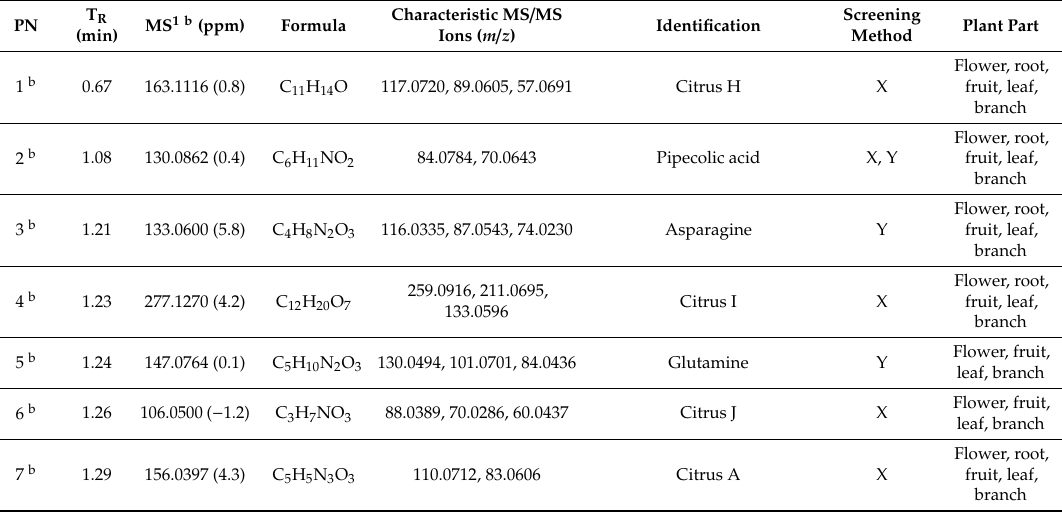
Figure 4. The tandem mass spectrometry (MS / MS) spectra and fragmentation behaviors of compounds 52 , 57 , and 78 . Table 1. The peak number (PN), retention time (TR), MS 1 , molecular formula, characteristic fragment ions, identification, screening method, and metabolic distribution of the screened and identified target